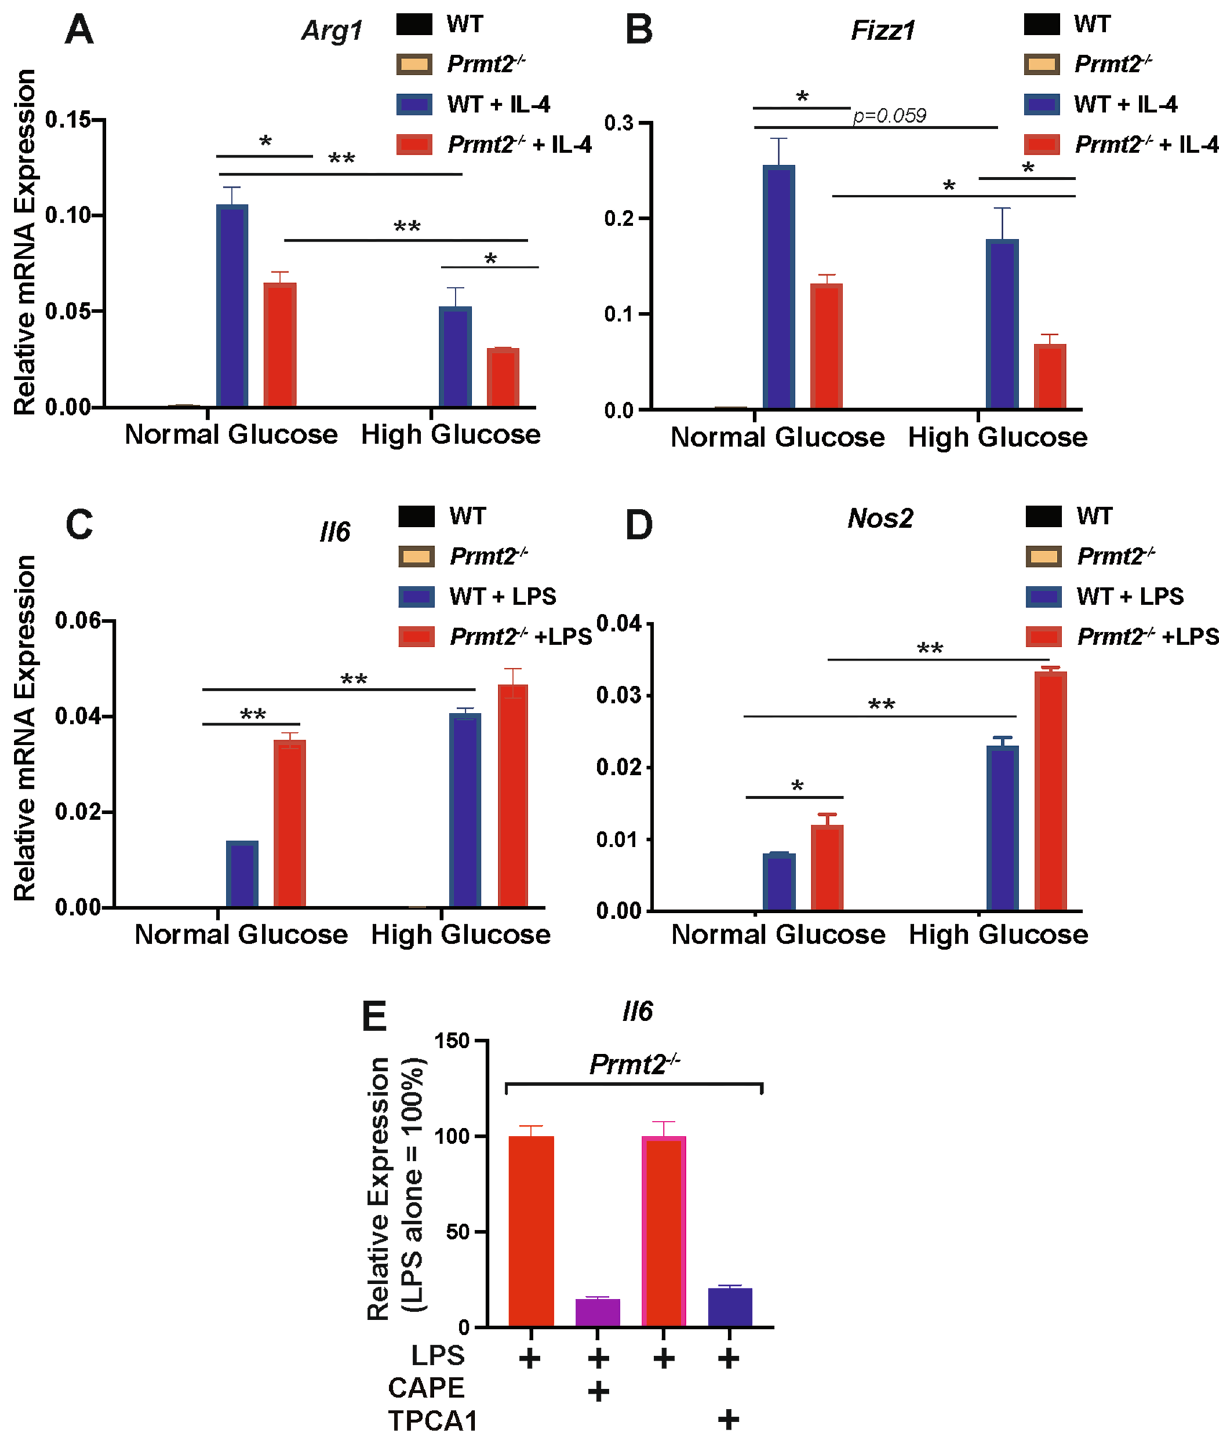
Figure 4. PRMT2 deficiency blunted the macrophage response induced by IL-4 and heightened the macrophage response to LPS in vitro. BMDMs from WT and Prmt2 −/− mice were differentiated into M0 (unactivated) macrophages in normal d + l-glucose (100 mg/dL d-glucose + 350 mg/dL l-glucose) or high d-glucose (450 mg/dL) for 7 days, and then treated with or without IL-4 (to induce M2 polarization) or with or without LPS (to induce M1 polarization). RNA was prepared and qPCR was performed on the M2 marker genes ( A ) arginase 1 ( Arg1 ) and ( B ) Fizz1 , and the M1 markers ( C ) Il6 and ( D ) Nos2 , and expression normalized to cyclophilin A is shown (n = 3). Data (means ± SEM) were analyzed using one-way ANOVA followed by Bonferroni’s multiple comparison test. *p < 0.05 and **p < 0.001. ( E ) LPS induction of Il6 is NF-kappa B dependent. Prmt2 −/− BMDMs were differentiated in normal glucose as above. Cells were pretreated for 2 h with NF-kappa B inhibitors CAPE (5 μM), or TPCA1 (5 μM) and then treated with LPS for 6 h. RNA was isolated and Il6 expression was determined by qPCR relative to cyclophilin A1 and is shown as percent relative to untreated cells, which was set to 100%. The data presented are means with error bars representing the range of the means from an experiment that was repeated